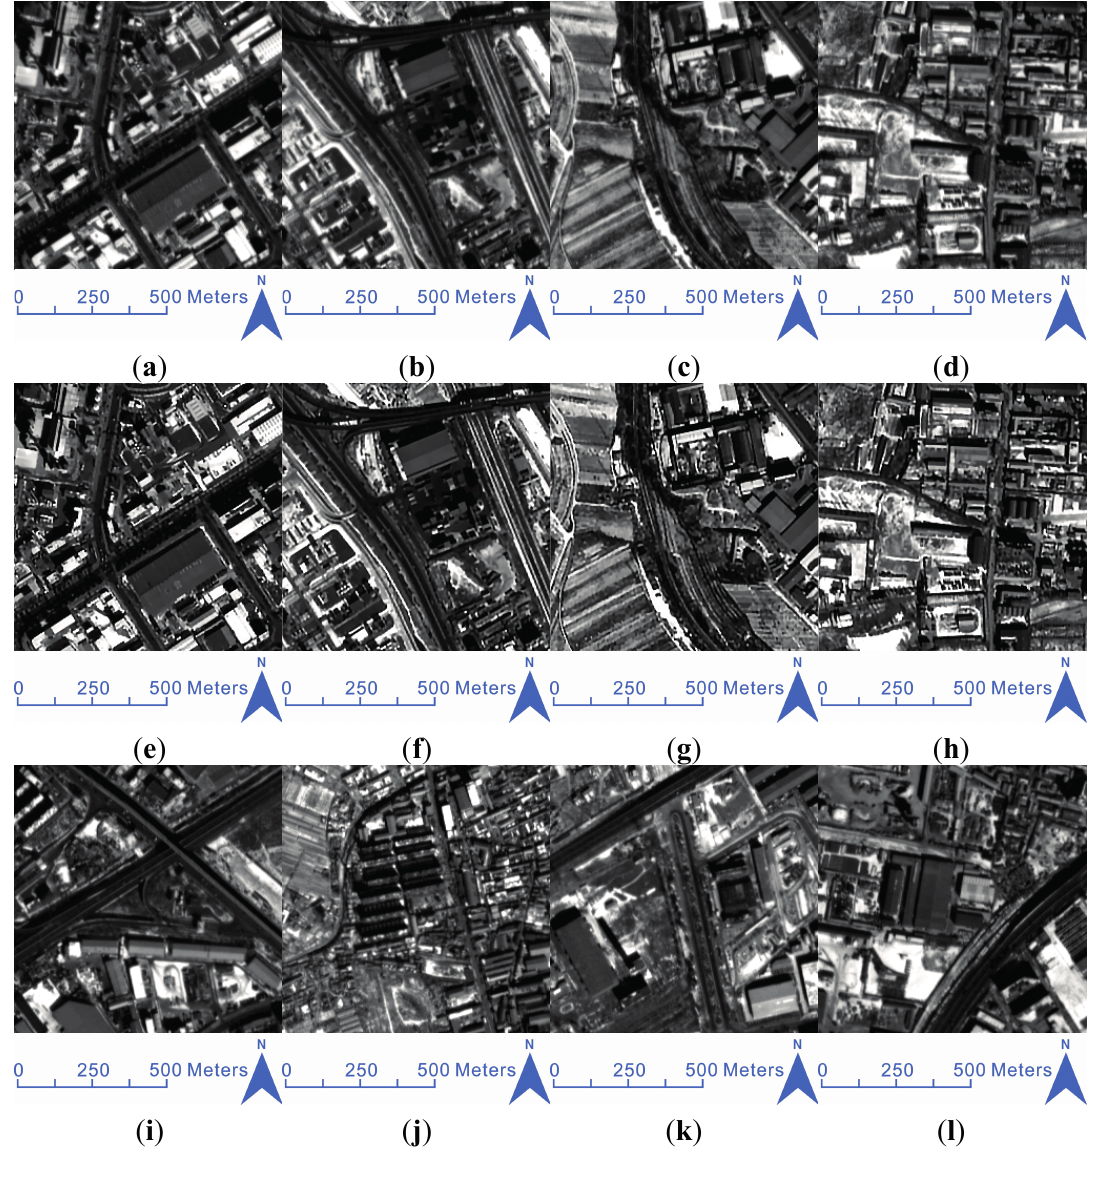
Figure 16. Restoration performance with the ZY-3 Panchromatic images: ( a – d ) are the original sub-images of experiments 1–4. ( e – h ) are the corresponding restored images of AM-KEdge. ( i – l ) are the original sub-images of experiments 5–8. ( m – p ) are the corresponding restored images of